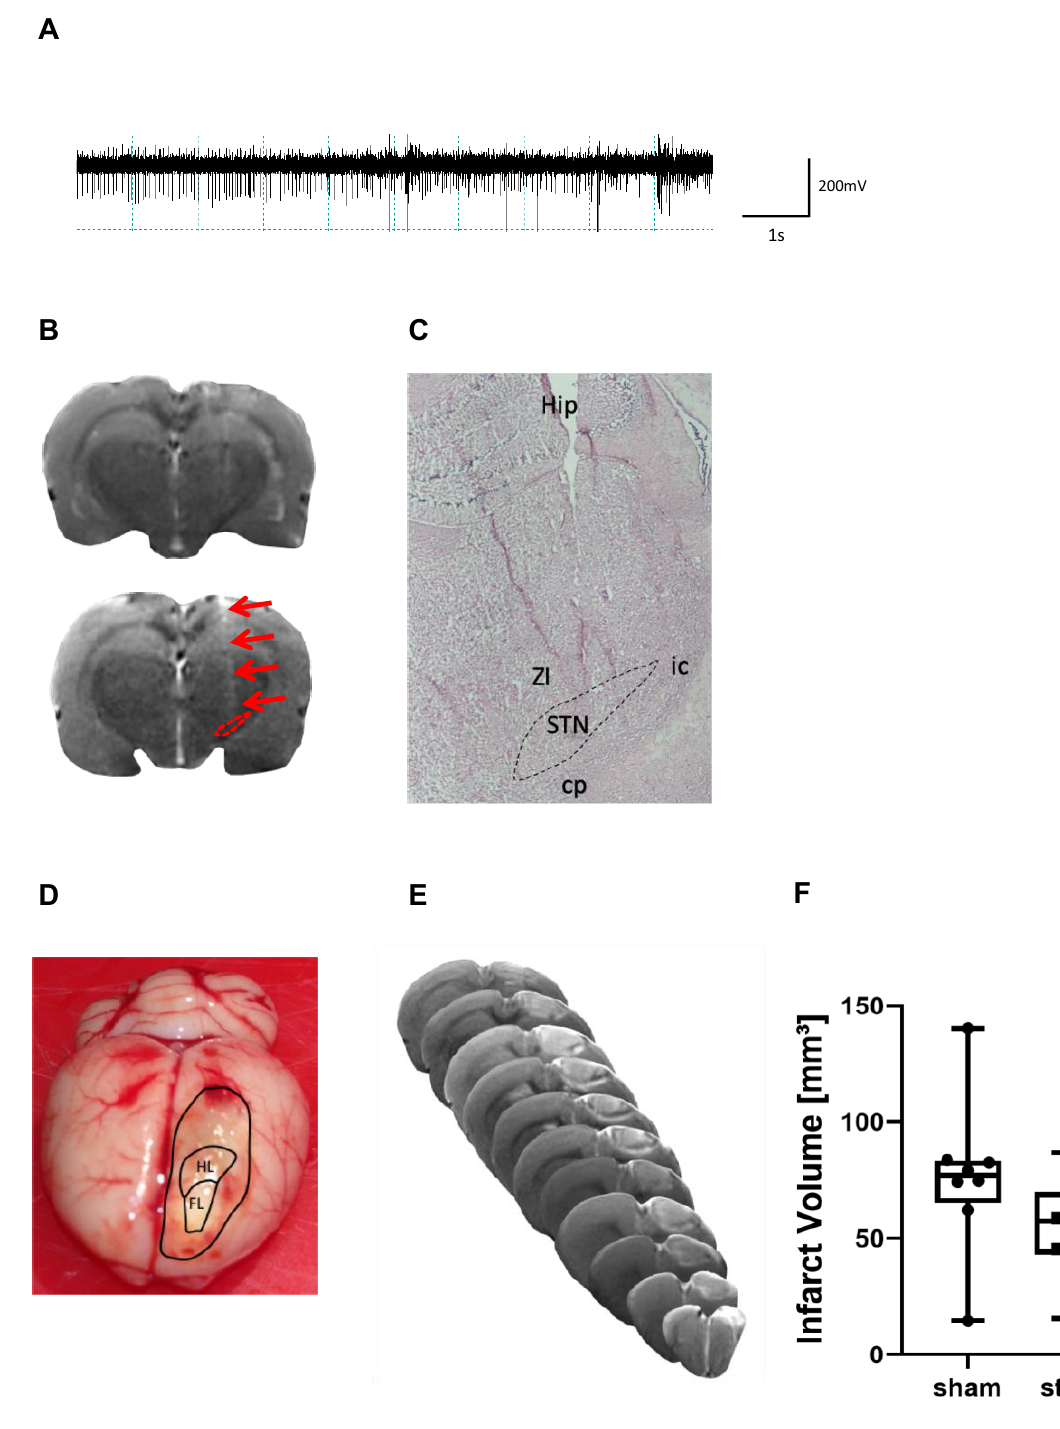
Figure 1. Placement of stimulating microelectrode and determination of infarct size. ( A ) Representa- tive tracing of the typical activity of STN-neurons; ( B ) representative T2w MR scan of a brain slice demonstrating the STN (dashed red circle) as well as the tract of the implanted electrode (red arrows); ( C ) representative HE-stained brain section obtained from the level of the STN demonstrating that the electrode is placed in the STN (magnification: × 40); Zi, zona incerta, Hip, hippocampus, cp, cerebral peduncle, ic, internal capsule; ( D ) macroscopic view of a rat brain after removing from the skull.